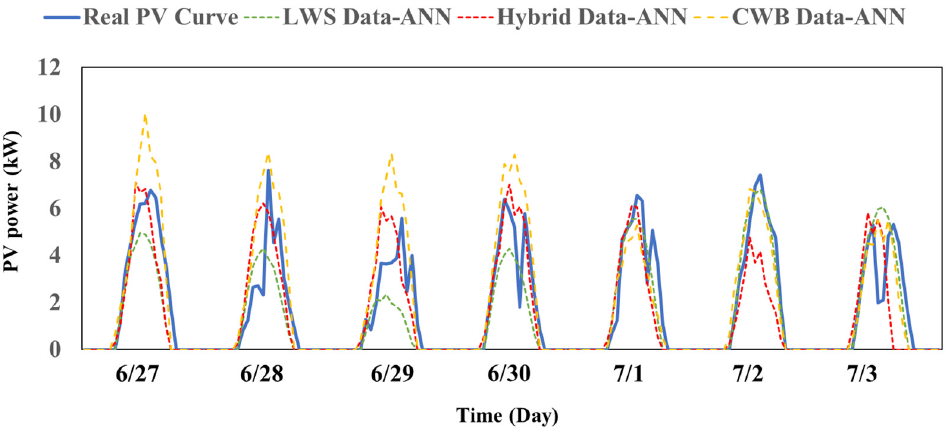
Figure 7. The PV power forecasting results of the ANN model.